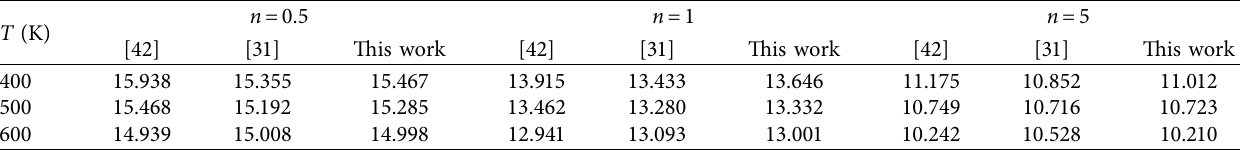
Table 4: Nondimensional natural frequencies ( Ψ � ( ω a 2 / h )[ ρ E m and ρ m at T 0